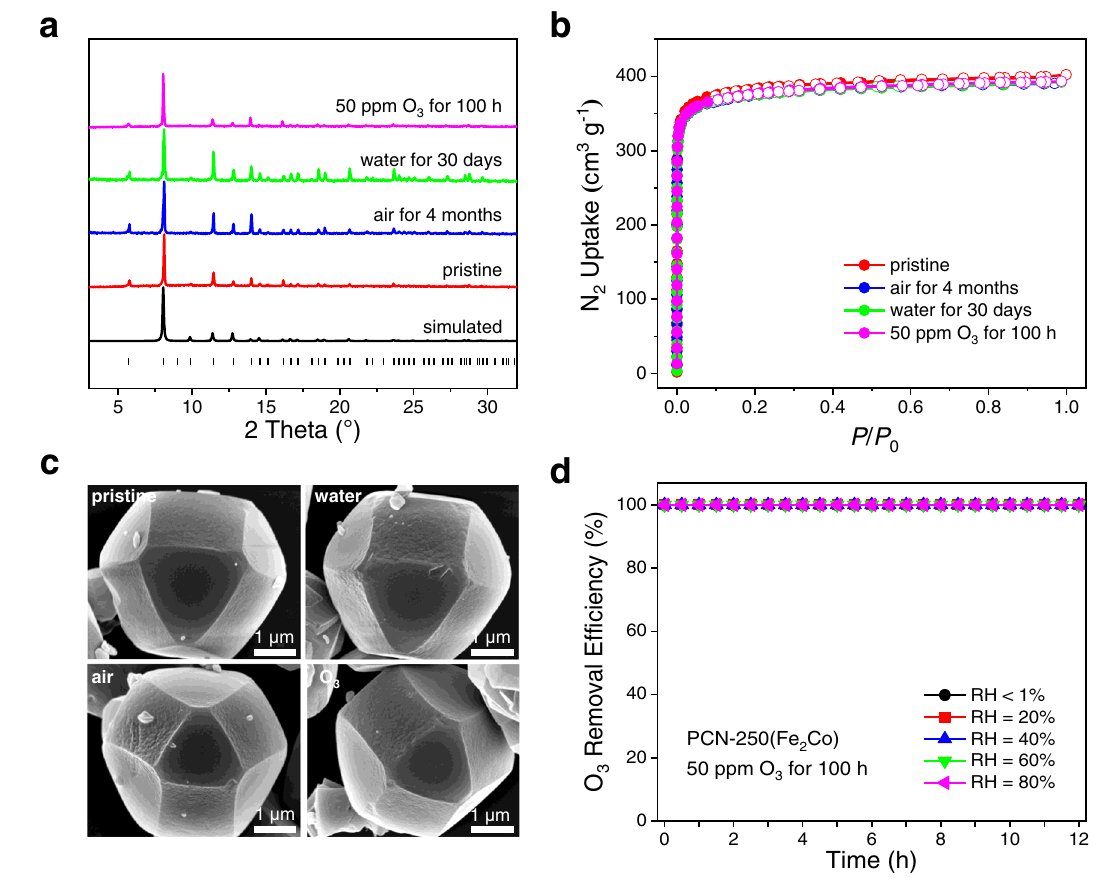
Fig. 3 | Stability tests for PCN-250(Fe 2 Co). a PXRD patterns, b N 2 sorption iso- therms, and c SEM images of the pristine and stability-tested PCN-250(Fe 2 Co) samples. d O 3 removalef fi ciencies for PCN-250(Fe 2 Co)after50 ppmO 3 treatment.